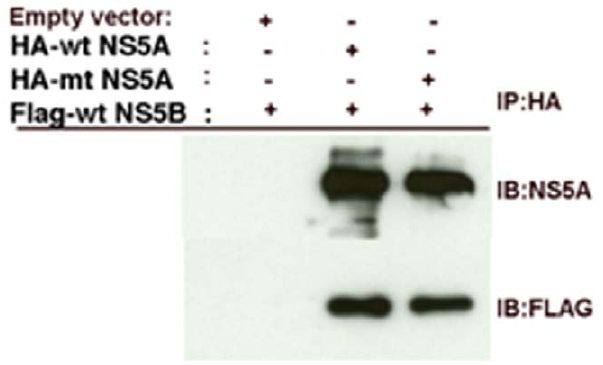
Figure 4. Wild-type and mutant NS5A’s do not differ in binding NS5B. 293T cells were co-transfected with either HA-wt NS5A or HA-mt NS5A together with FLAG-wt NS5B (Con 1b). The cells were harvested 48 hours after transfection and immunoprecipitated with HA-specific antibody. Immunoprecipitates were western blotted and probed with monoclonal antibody specific for NS5A and anti-FLAG antibody to detect NS5A and NS5B respectively. Signal was detected by chemilu- minescence assay (IP-immunoprecipitation,